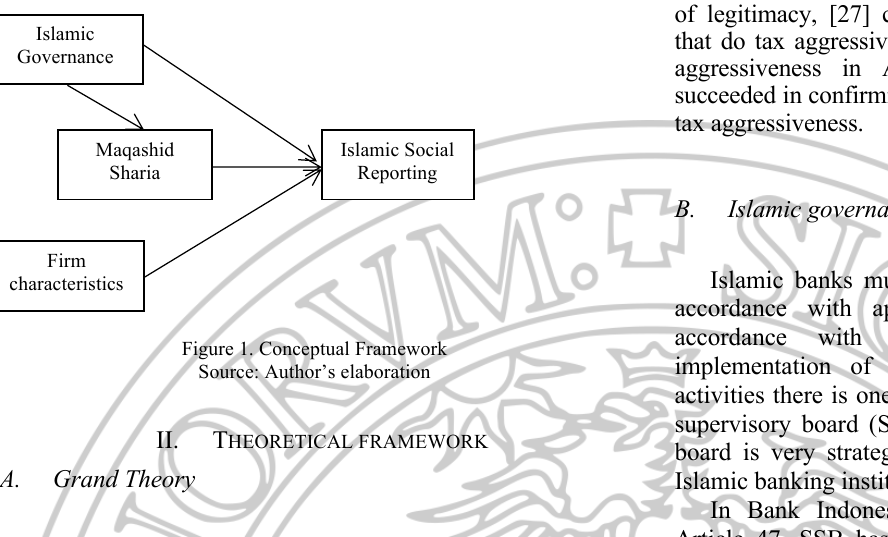
Figure 1. Conceptual Framework Source: Author’s